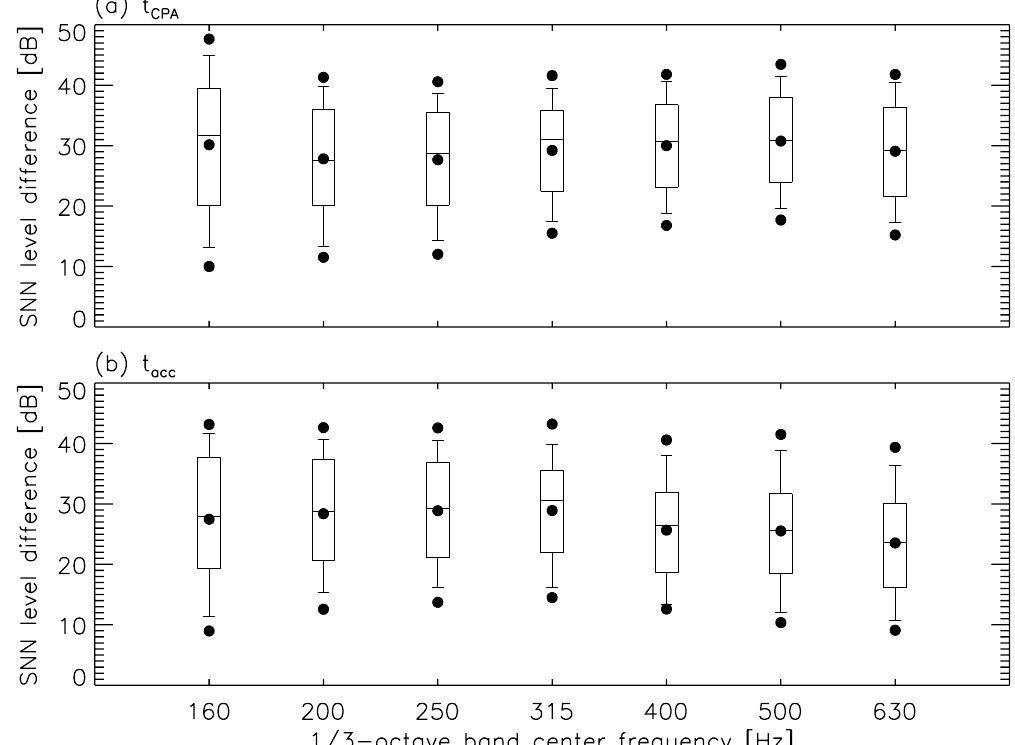
Figure 10. Whisker plots of the signal-plus-noise-to-noise (SNN) level difference ( (cid:31) L ) for all 1/3-octave bands used in this work (see Table 4). ( a ) (cid:31) L distribution for signal recorded at t CPA (see Table 5). ( b ) (cid:31) L distribution for signal recorded at t acc (see Table 5). Percentiles are shown, from bottom to top, at 5% (dot), 10%, 25%, 50%, 75%, 90%, and 95% (dot). The central dot gives the mean of the